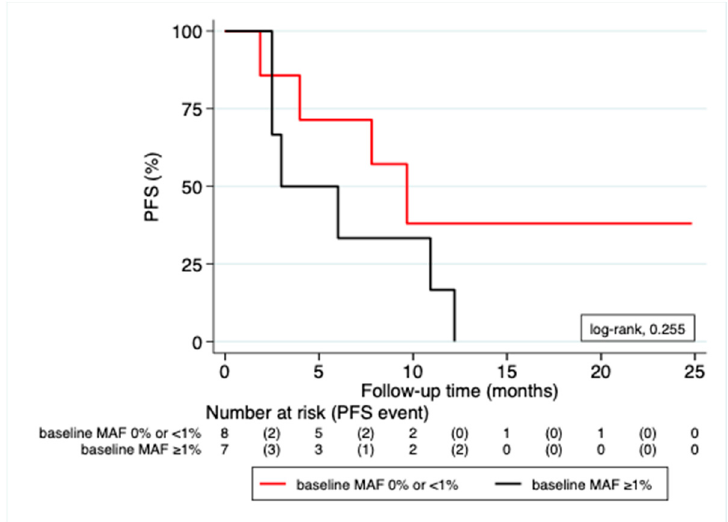
Figure 4. Comparison between groups of patients with high ( ≥ 1%) versus low/undetectable (<1%) baseline MAF for PFS. Kaplan–Meier curve for PFS according to MAF levels at baseline (pretreatment)—high versus low/undetectable. PFS: progression-free survival; MAF: mutant allele frequency.